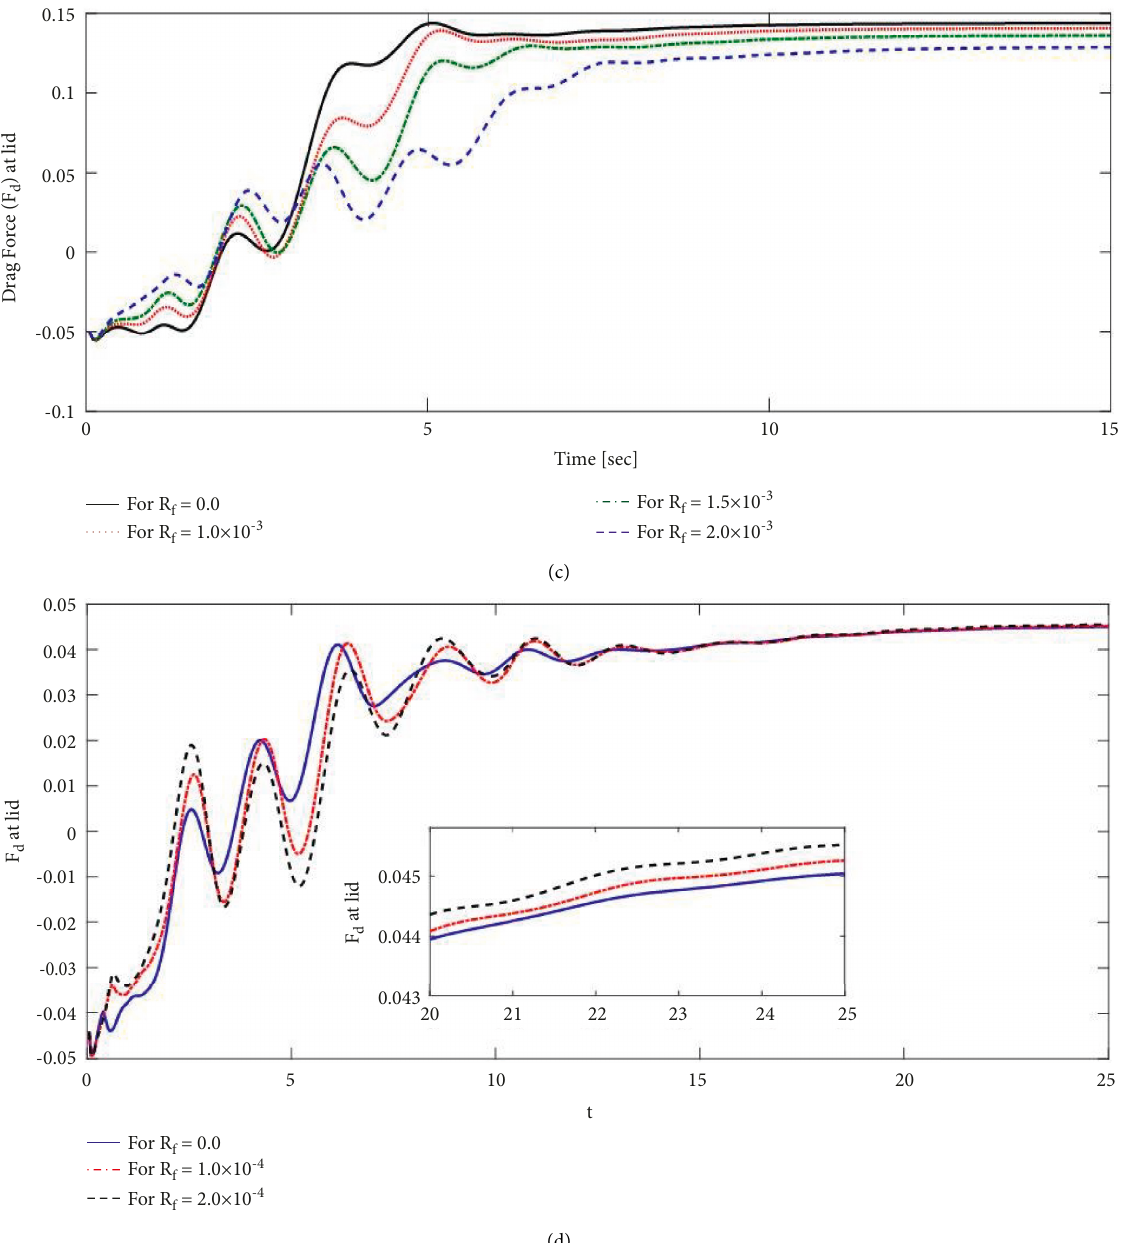
� 500, (b) for Re � 1000, (c) for Re � 2000, and (d) f . (a) For Re